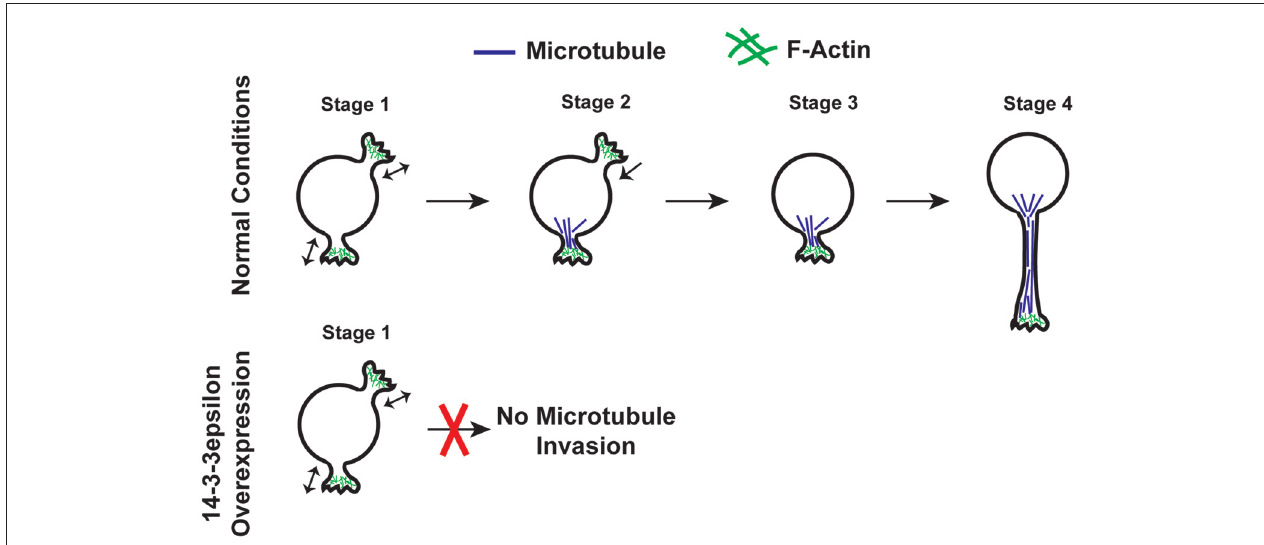
FIGURE 4 | Schematic illustration of neurite initiation. Illustration of the typical stages of neurite initiation. In stage 1, actin based lamellipodia type structures rapidly form and retract. In stage 2, microtubules begin to invade and stabilize lamellipodia structures preventing their collapse. In stage 3, neurites that have been invaded by microtubules become stable structures and begin to extend in stage 4. The overexpression of 14-3-3 ε prevents the invasion of microtubules into forming neurites as seen in stage 2, thus disrupting neurite formation.